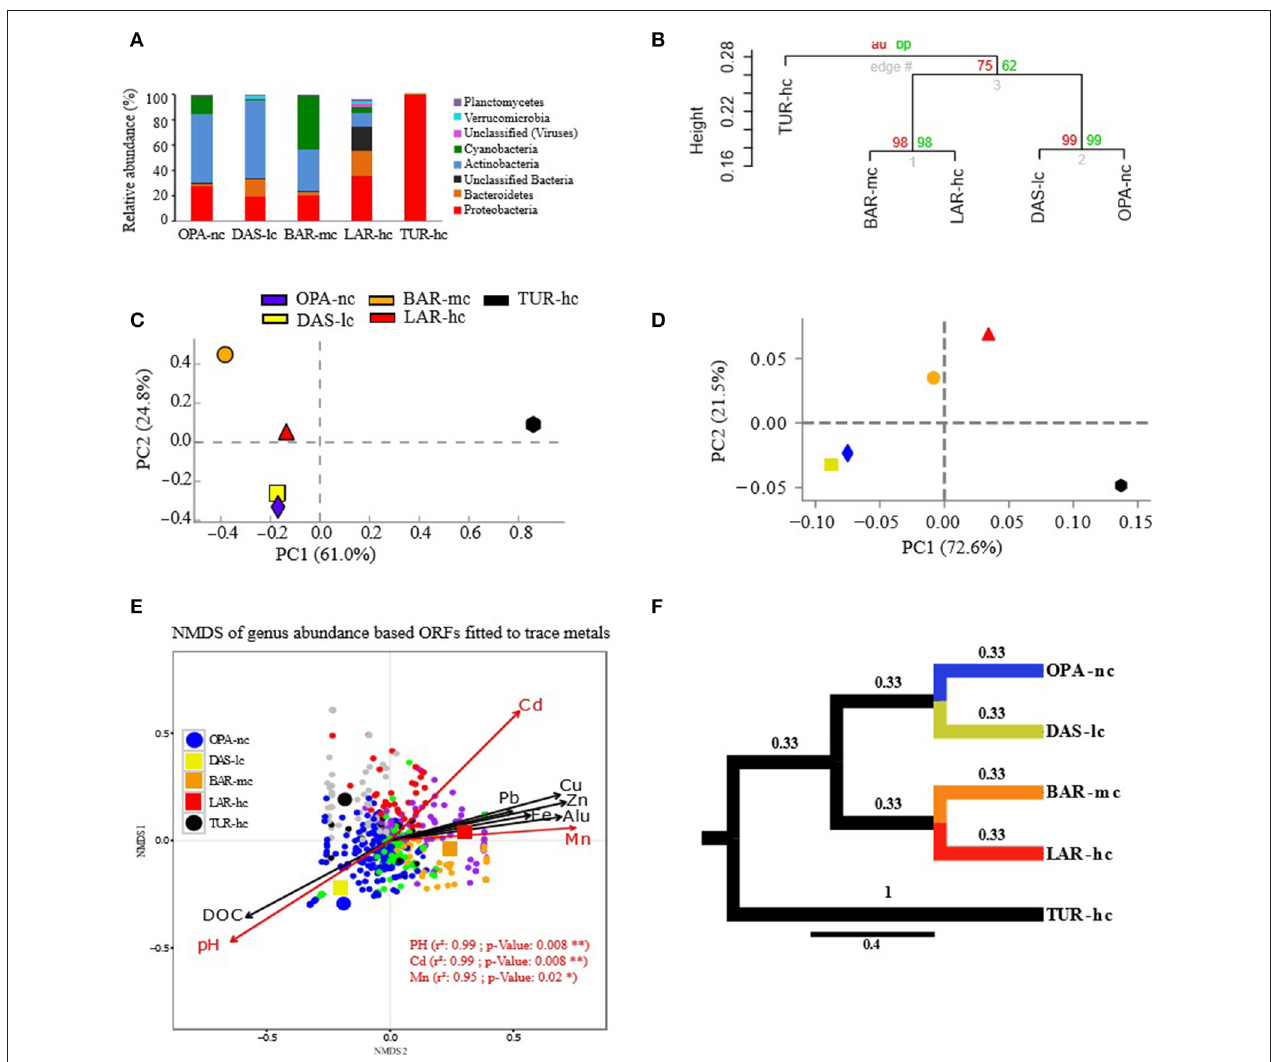
FIGURE 2 | Composition of metacommunities based on the ORF approach. (A) Metacommunity composition (y-axis) is shown in stacked bars for each lake metagenome (x-axis). Only phyla with relative abundance (RA) greater than 1% are shown. (B) Hierarchical clustering of samples based on genus RA using Ward’s method and Bray–Curtis dissimilarity distance, bootstrap AU (Approximately Unbiased) p -value and BP (Bootstrap Probability) values are shown on the nodes. (C,D) Principal Component Analysis (PCA) of samples based on genus RA with different annotation parameters of alignment length cutoffs (50pb in c and 30 bp in d) and identity threshold (85% in C and 60% in D ). (E) NMDS of genera abundance fitted to trace metals was performed with Bray–Curtis distance, three dimensions were a priori defined for distance rank ordination and stress value was below 0.05. Cadmium (Cd), Manganese (Mn), and pH significantly fitted with NMDS axes are highlighted in red. NMDS loadings (NMDS1, NMDS2), and P -value of correlation r 2 of trace metals were reported in Supplementary File S6 . Each small dot represents the ordinated genus, while each large point represents the lake communities’ samples using a circle for OPA-nc in blue and the control TUR-hc in black, and the connected lakes are illustrated with squares (LAR-hc in red, BAR-mc in orange and DAS-lc in yellow). Genus plot coordinates, clusters and dot labels are shown in Supplementary File S4 . (F) Tree based Unifrac distance computed with mothur is indicated by branch lengths. All these results were obtained using the ORF based approach with 85% identity threshold, e -value of 10 − 12 , minimum alignment length of 50 base pairs, and the lowest common ancestor (LCA) algorithm for taxonomic assignment. OPA-nc (Opasatica Lake) is the negative control; DAS-lc (Dasserat Lake) is low polluted; BAR-mc (Arnoux Bay) is medium polluted; LAR-hc (Arnoux Lake) is highly polluted, and TUR-hc (Turcotte Lake) is the positive control of